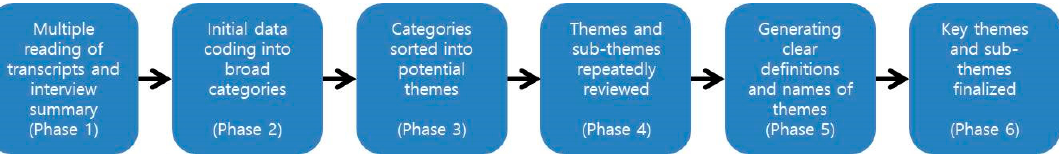
Figure 1. Data analysis process.